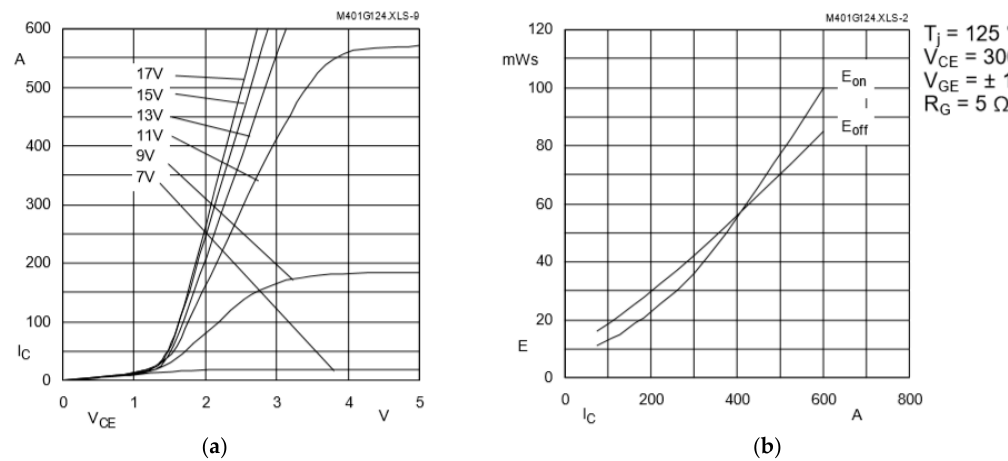
Figure 4. IGBT features. ( a ) IGBT characteristic ( b ) IGBT switching losses.